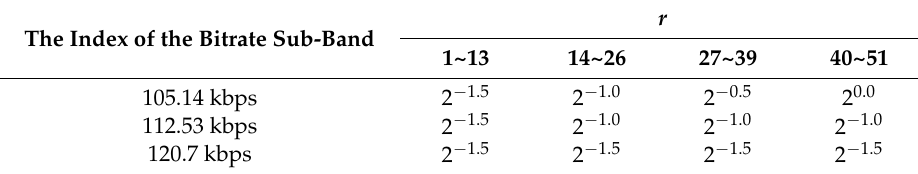
Table 2. The q stepsize allocation for three types of bitrates.